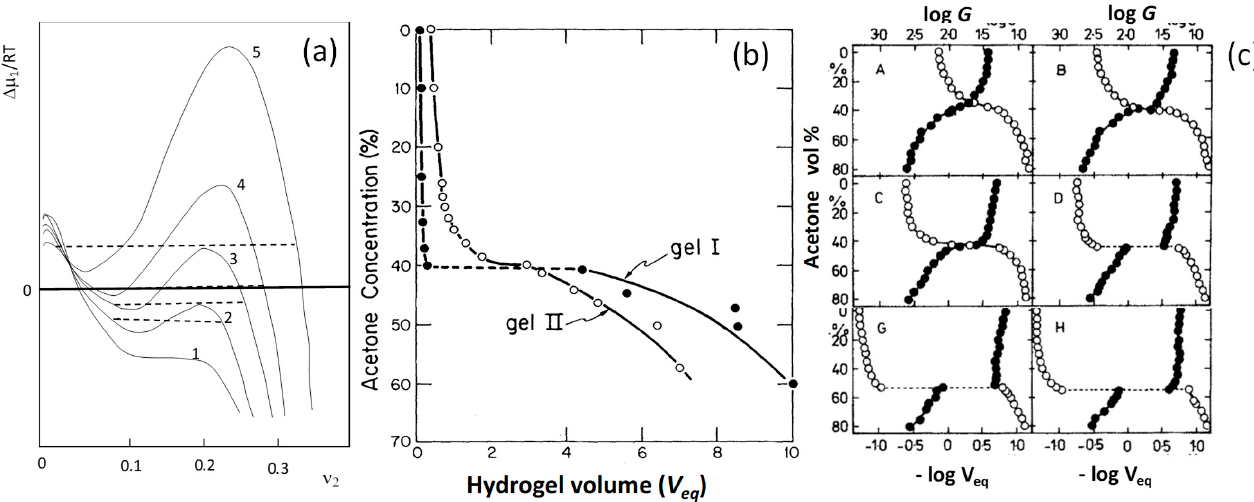
Figure 2. ( a , b ) The pioneering findings of Dusek ( a ) and Tanaka ( b ) on the volume phase transition in gels. ( a ) The dependence of the excess chemical potential ∆ μ 1 of the solvent on the polymer volume fraction 𝜐 2 . The numbers 1 to 5 indicate increasing cross-link density. From [7] with permission from the John Wiley and Sons, Inc. ( b ) The volume V eq of PAAm hydrogels in acetone-water mixtures of various acetone contents. Filled and open symbols are the data for the gels cured in gelation tubes for 30 and 3 days, respectively. From [8] with permission from the American Physical Society. ( c ): Double-logarithmic plots showing the inverse of the hydrogel volume V eq (open symbols) and the modulus G in g·cm − 2 (filled symbols) both plotted against the acetone concentration in acetone-water mixtures for PAAm hydrogels. The curing times are 0.13 (A), 3 (B), 6 (C), 12 (D), 78 (G), and 97 days (H). From [14] with permission from the American Chemical Society.